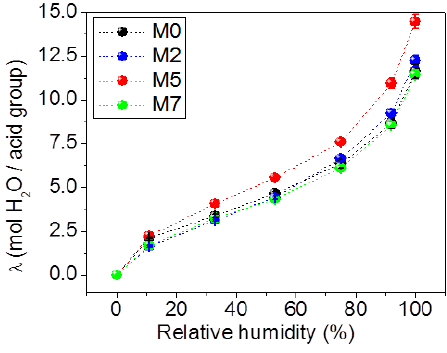
Figure 2. Number of water molecules per acid site of membrane samples.